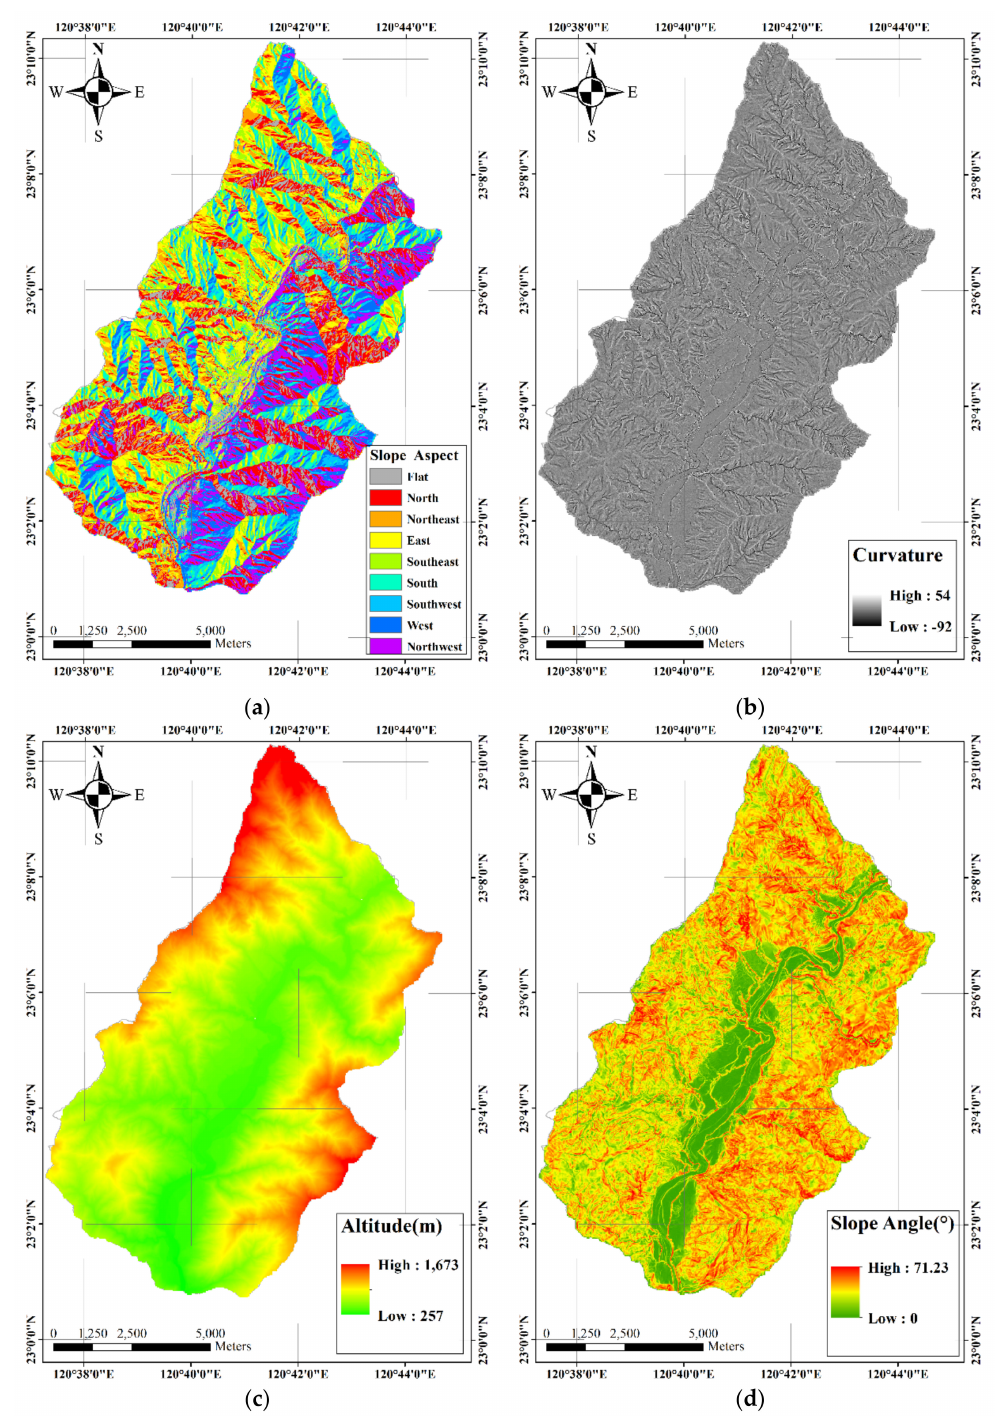
Figure 2. Topographic layers used in this study. ( a ) Aspect, ( b ) curvature, ( c ) elevation, and ( d )